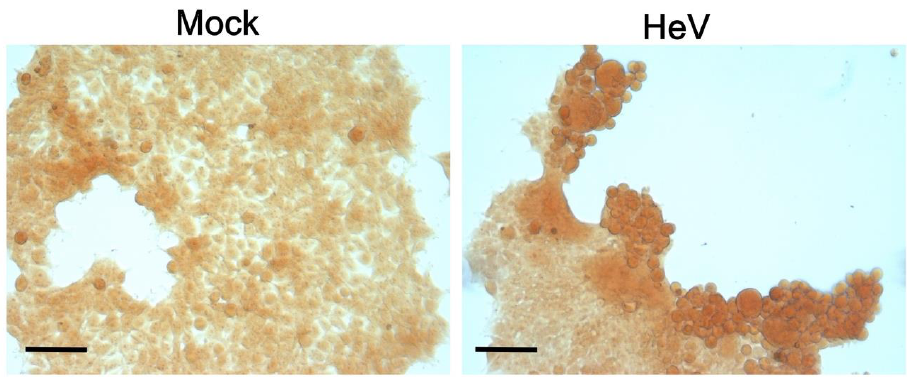
Figure 12. CR capture by non-infected HEK 293T cells (Mock) or by cells infected by HeV (MOI 0.00025) at 48 post-infection. Scale bar: 100 μ m.